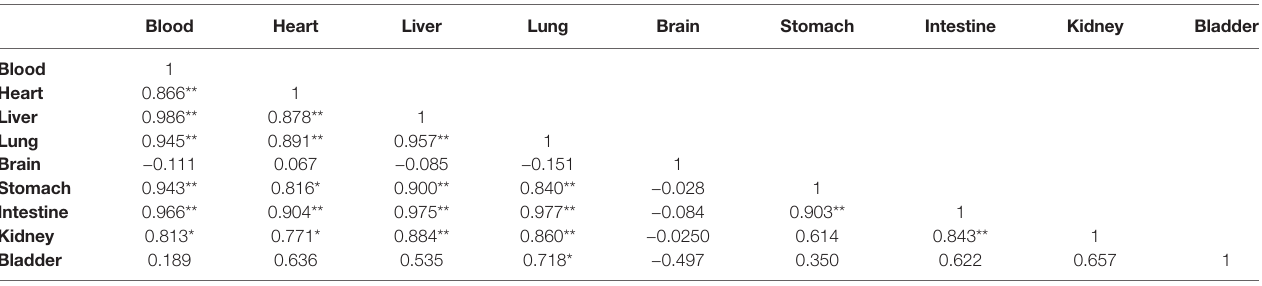
TABLE 2 | Correlation analysis of boron concentrations in the analyzed samples in rats. Blood Heart Liver Lung Brain Stomach Intestine Kidney Bladder Blood